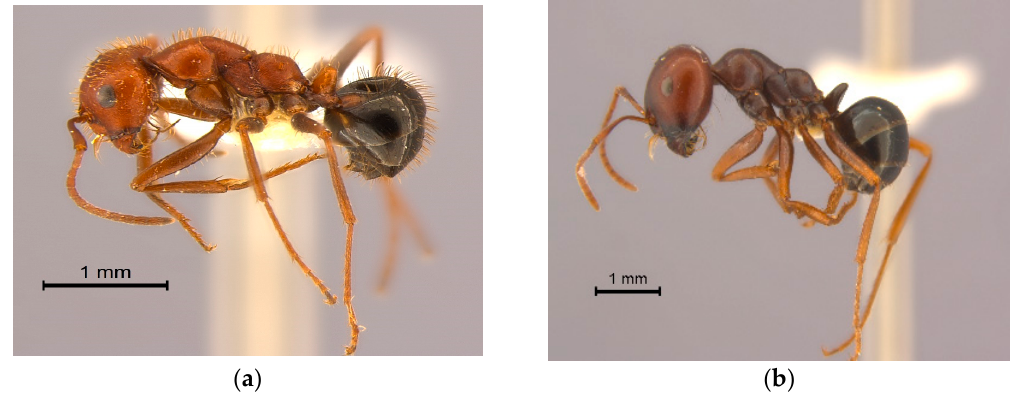
Figure 6. Representatives of the M. wheeleri radiation. ( a ) Member of Melophorus Group H; ( b ) Member of the M. wheeleri group.